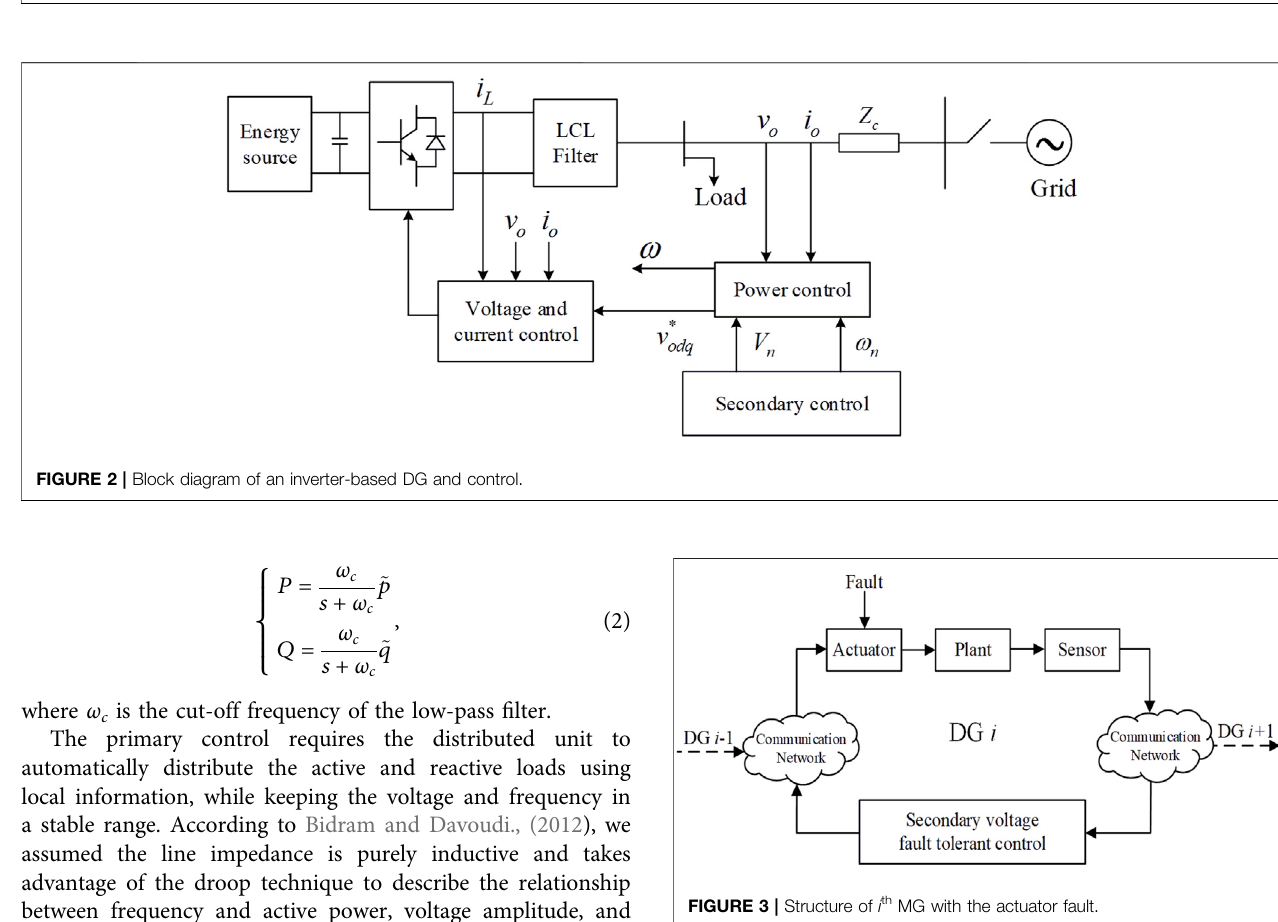
FIGURE 1 | Diagram of islanded MGs considering communication topology.